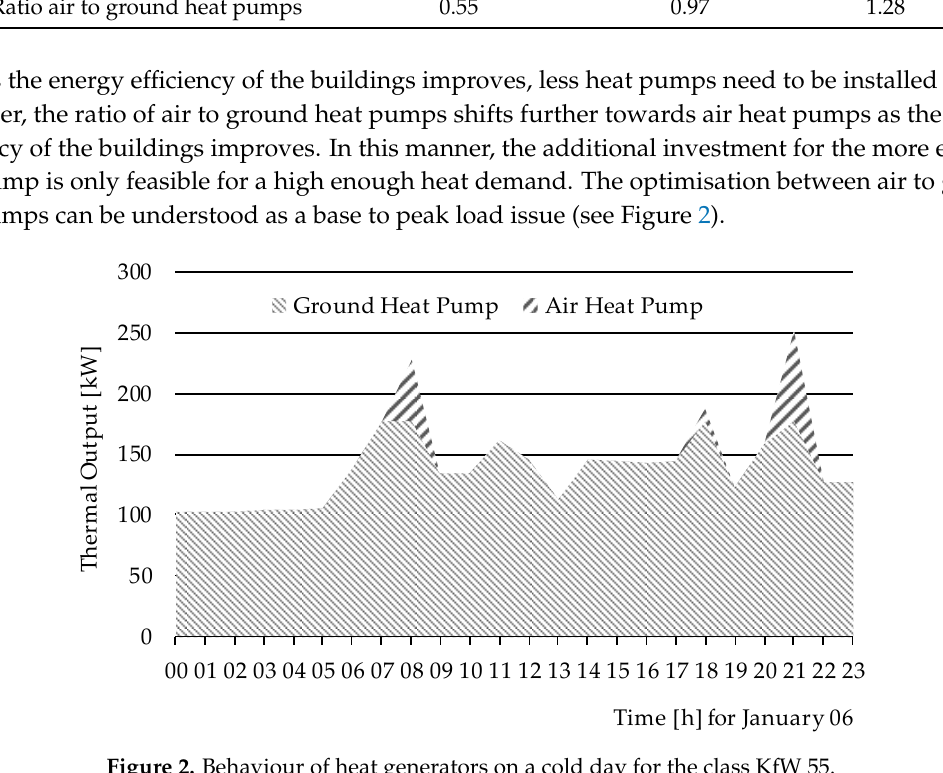
Figure 2. Behaviour of heat generators on a cold day for the class KfW 55.